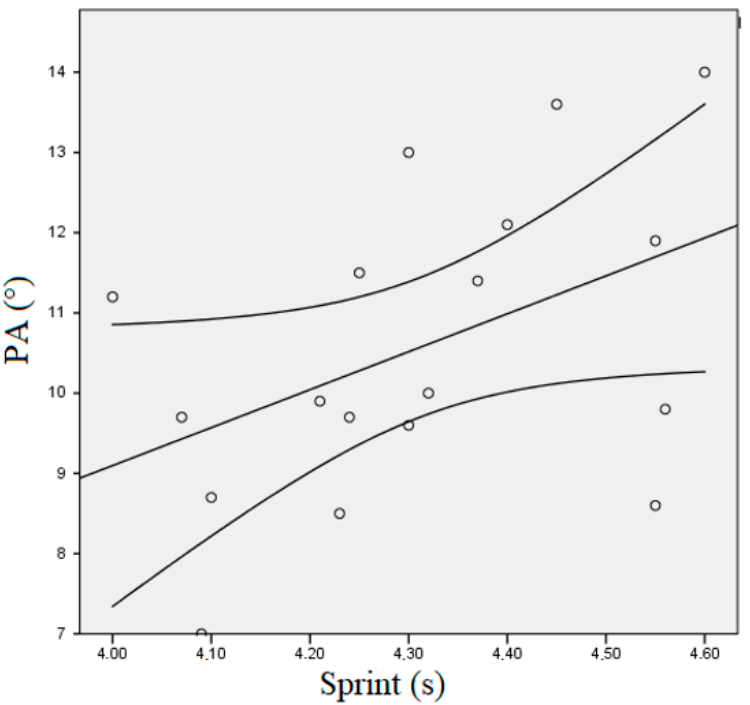
Figure 4. Scatter plot between PA of VL and 30-m Sprint. PA = pennation angle. The middle line represents the median and the parabolic lines represent the 95% confidence interval.